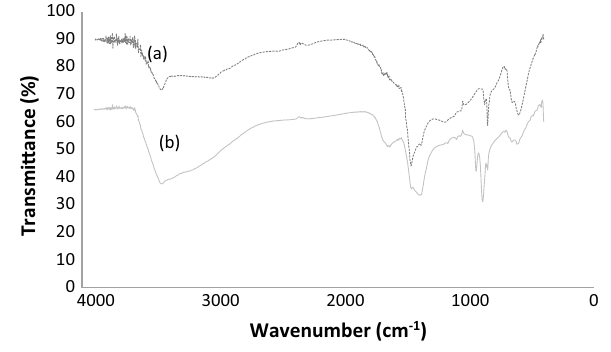
Fig. 4 FTIR spectra of LLAC a before and b after loading of Cr(VI)